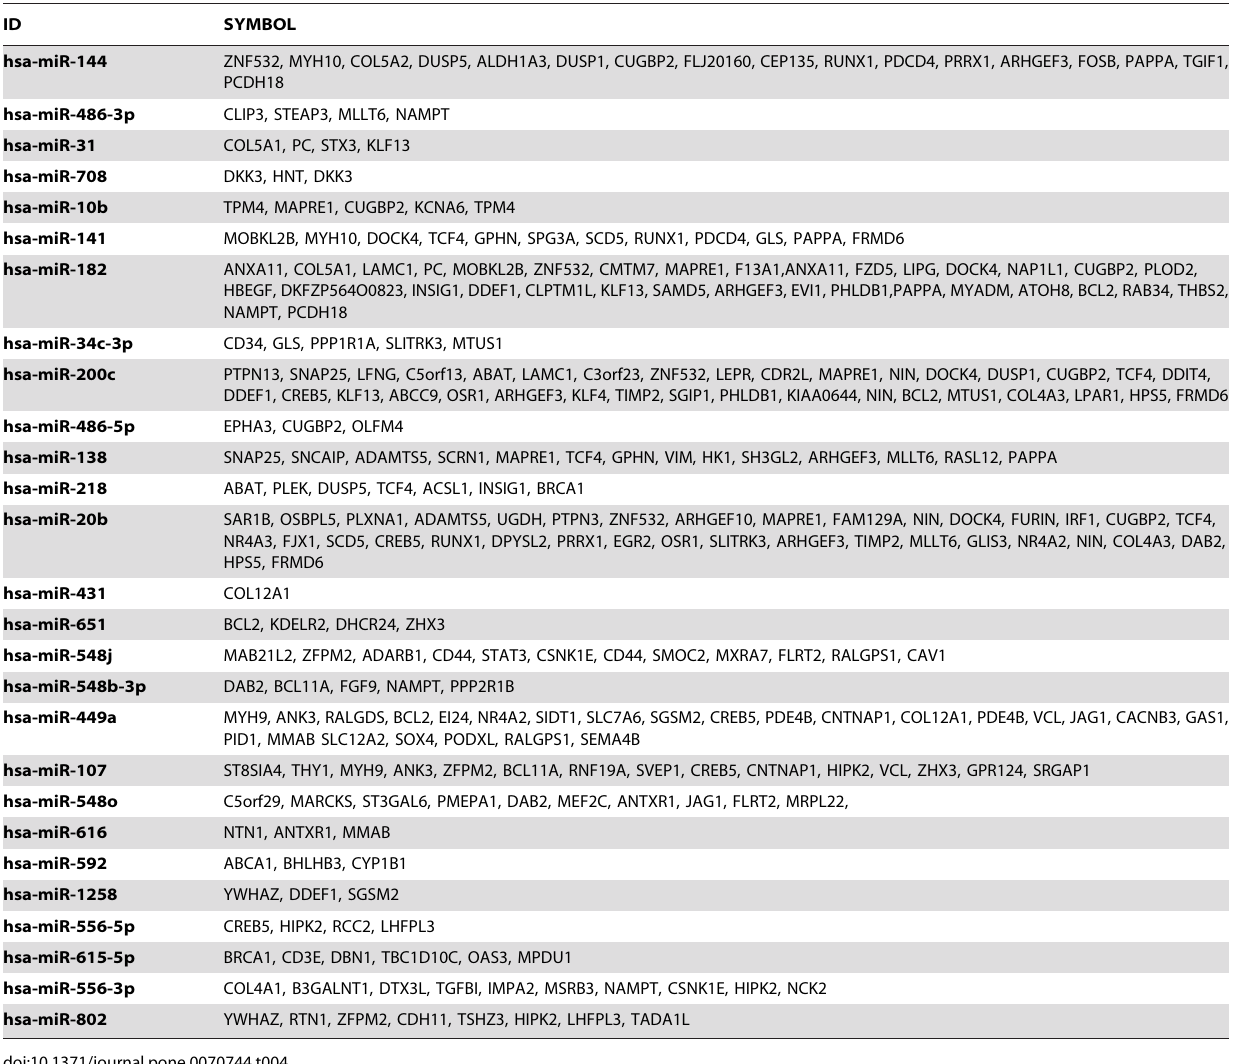
Table 4. mRNAs targeted by the modulated miRNA in chronic